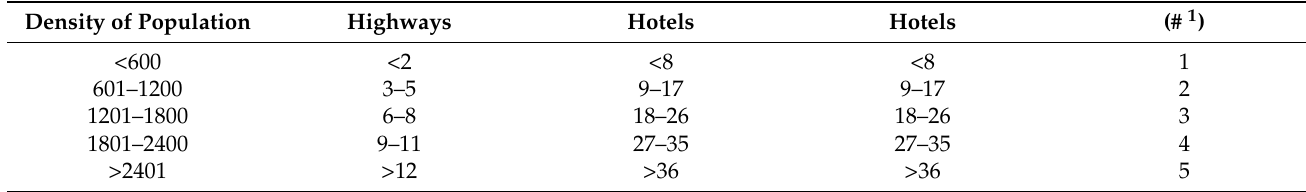
Table 1. Classification anthropogenic elements. Sources: [67,69].